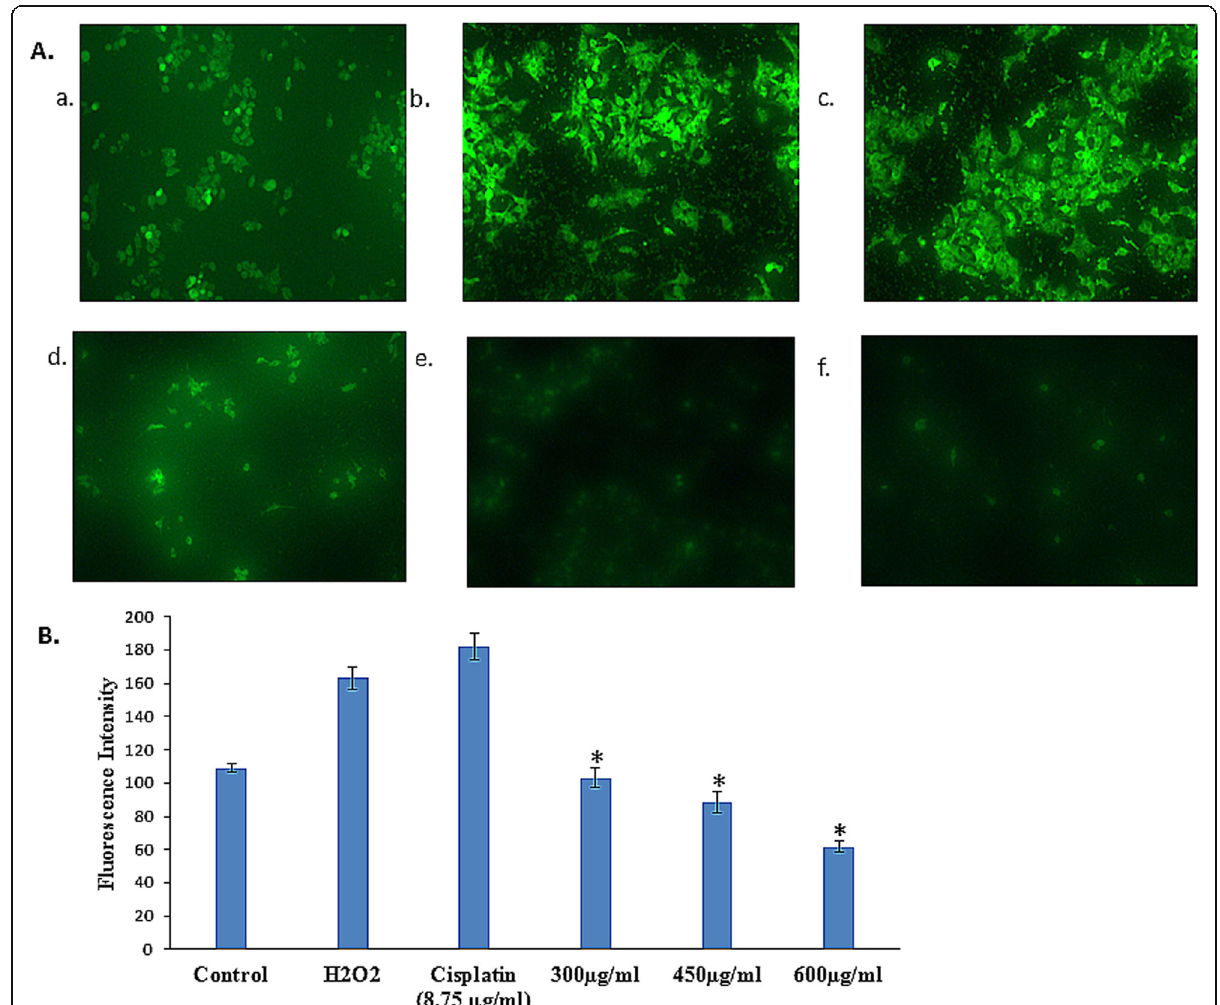
Fig. 4 Reactive oxygen species (ROS) determined by H 2 DCF-da assay showing reduction in intracellular ROS in treatment groups. a Fluorescence microscopic images showing reduction in ROS in MEUP treated cells (a), negative control (b), positive control (H 2 O 2 ) (c), cisplatin (IC 50 concentration) (d), MEUP (300 μ g/ml) (e), MEUP (450 μ g/ml) (f), MEUP (600 μ g/ml). ROS levels were reduced in the cells with increasing concentration of MEUP. b Fluorescence intensity of H 2 DCF-da in different treated cells determined by image j software. Results are expressed as mean ± SD. The asterisk represents a significant difference in cell deaths between control and treatment groups. ( P <